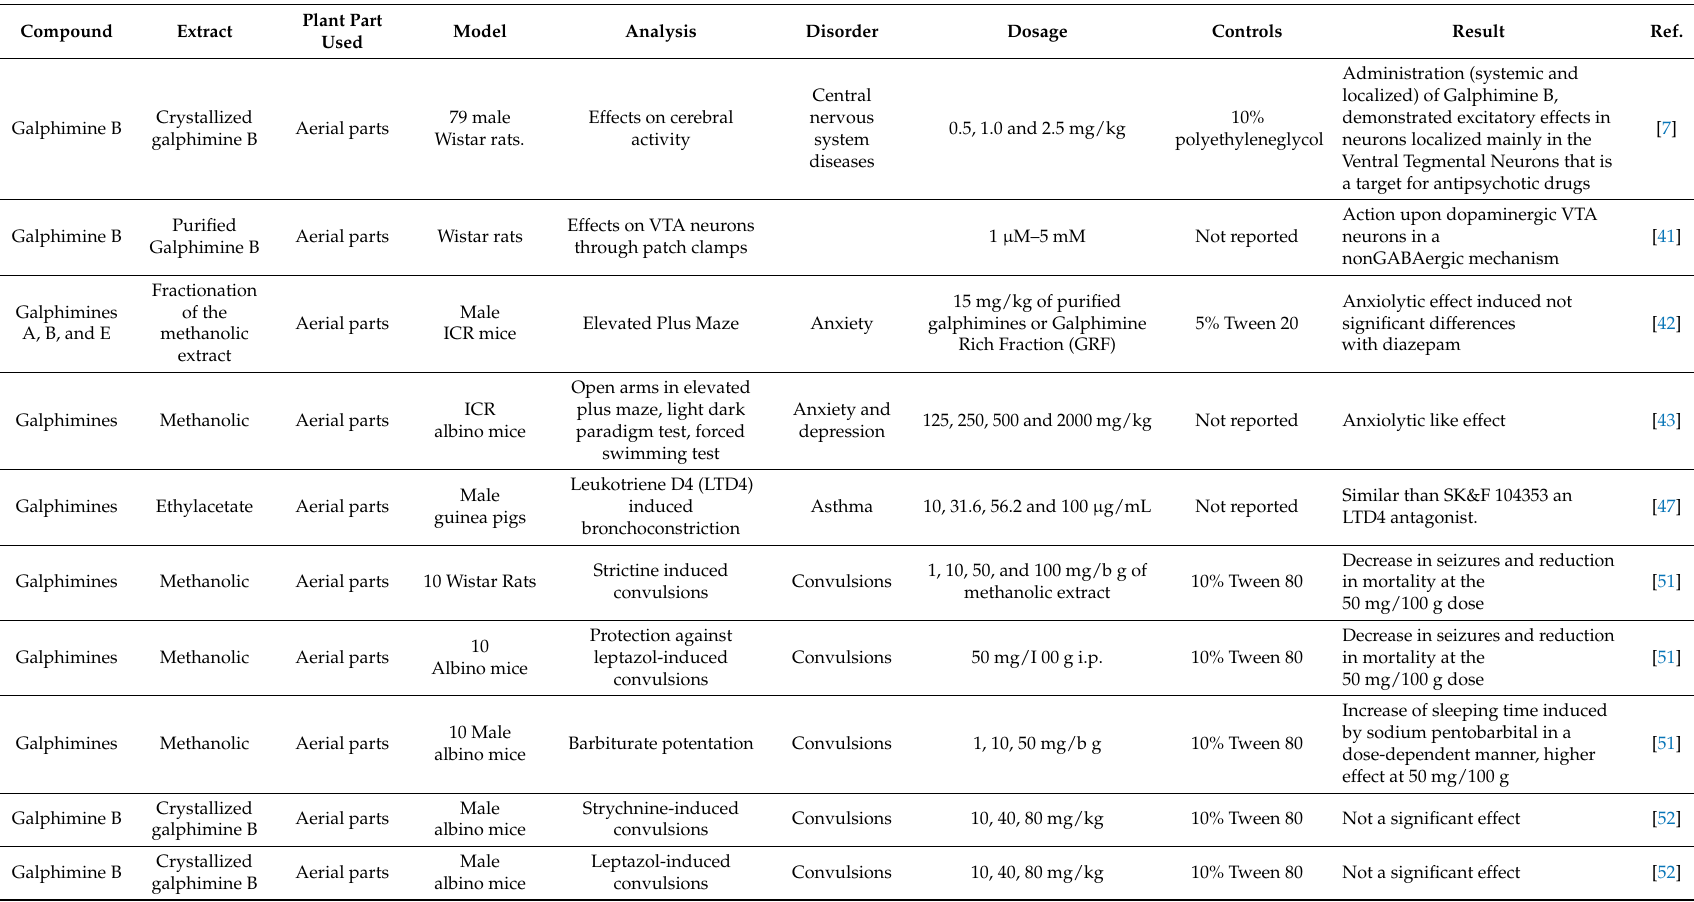
Table 2. Pharmacological effects of galphimines and related compounds from Galphimia glauca tested in vivo in animal